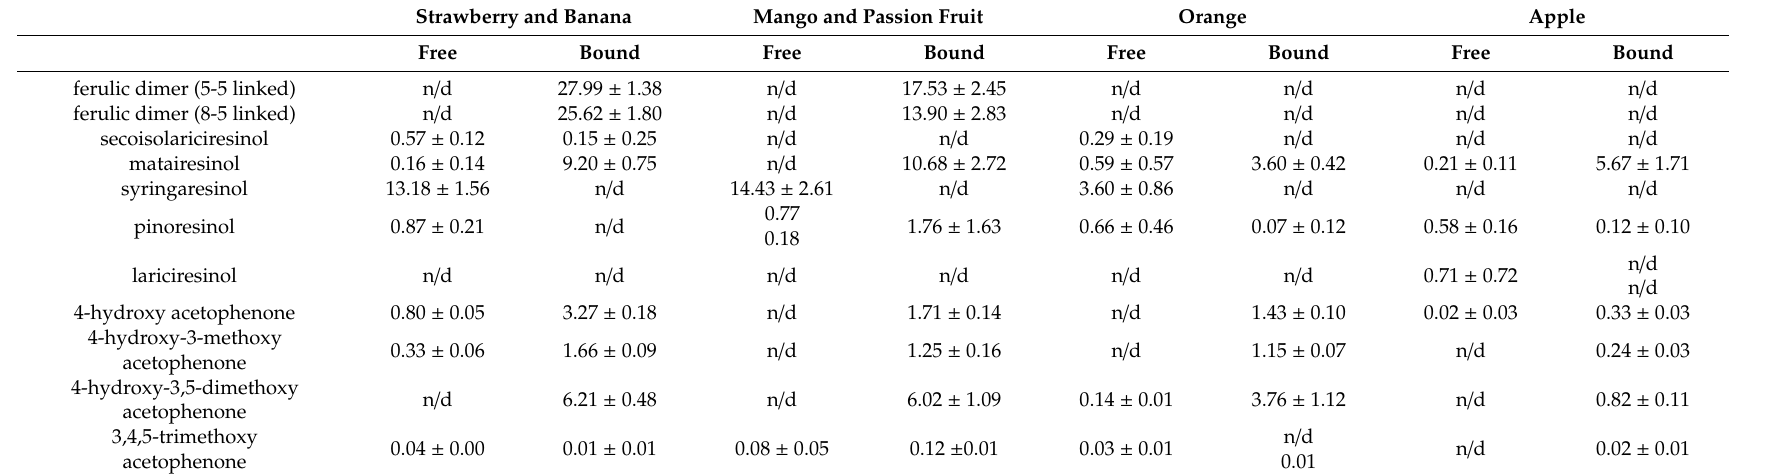
Table 3. Phenolic dimer, lignan, and acetophenone content of juice / smoothie samples. Strawberry and Banana Mango and Passion Fruit Orange Apple Free Bound Free Bound Free Bound Free